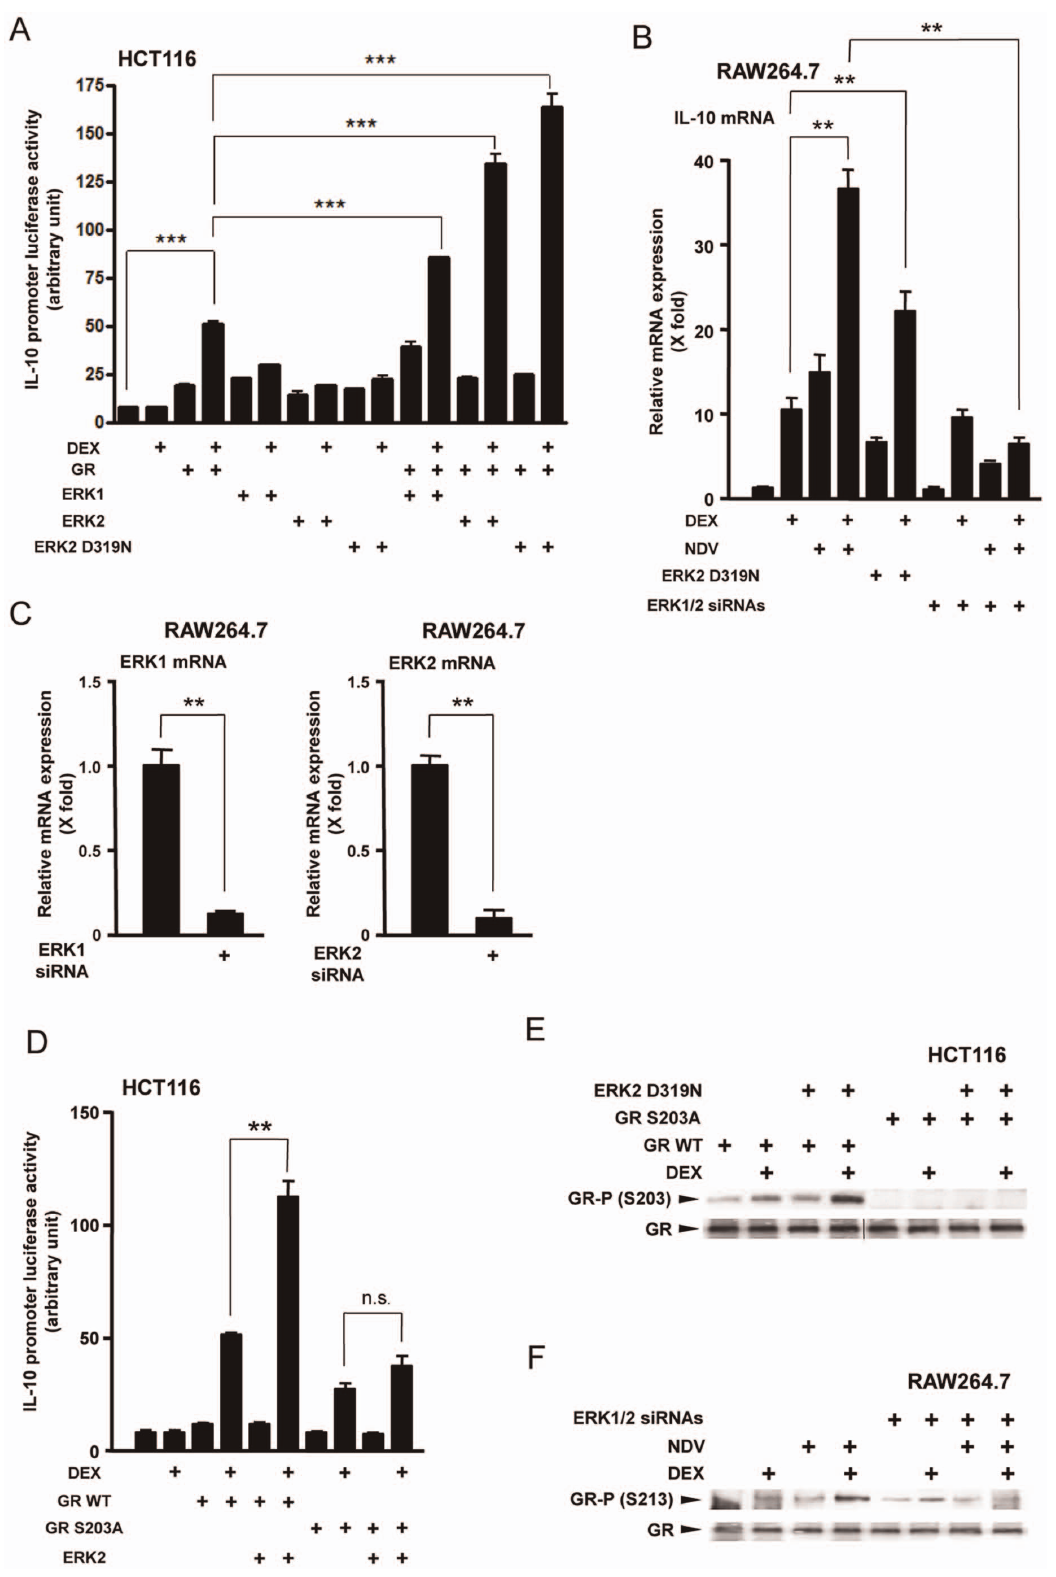
Figure 7. NDV infection increased IL-10 expression by phosphorylating GR at serine 203 (human) and 213 (mouse). A . ERK increased GR-induced transcriptional activity of the IL-10 promoter in HCT116 cells. HCT116 cells were transfected with wild type ERK1-, 2- or its constitutively active mutant ERK2 D319N-expressing plasmid in the presence of wild type human GR, together with the pGL3 reporter carrying the IL-10 promoter and the pGL4.73[ hRluc /SV40] control plasmid. Cells were subsequently treated with DEX (10 2 6 M) for 24 hours. Bars represent means and standard